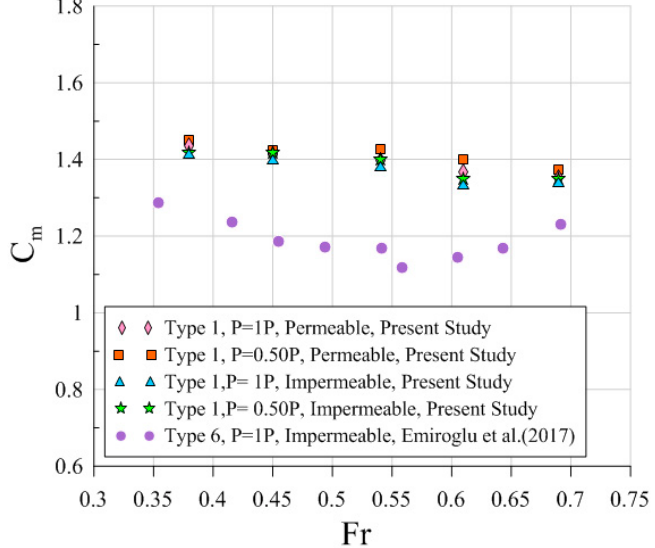
Figure 22. Comparison of antivortexes in the present study with antivortexes used by Emiroglu et al. [18] in terms of discharge coefficient values. et al. [18] in terms of discharge coefficient